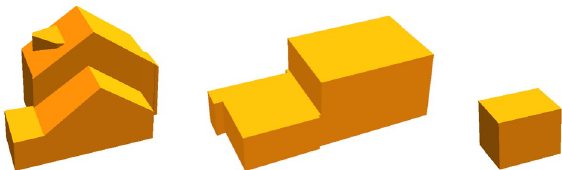
Figure 10 . Examples for the three roof types in the data set. From left to right: slanted, multiple horizontal, single